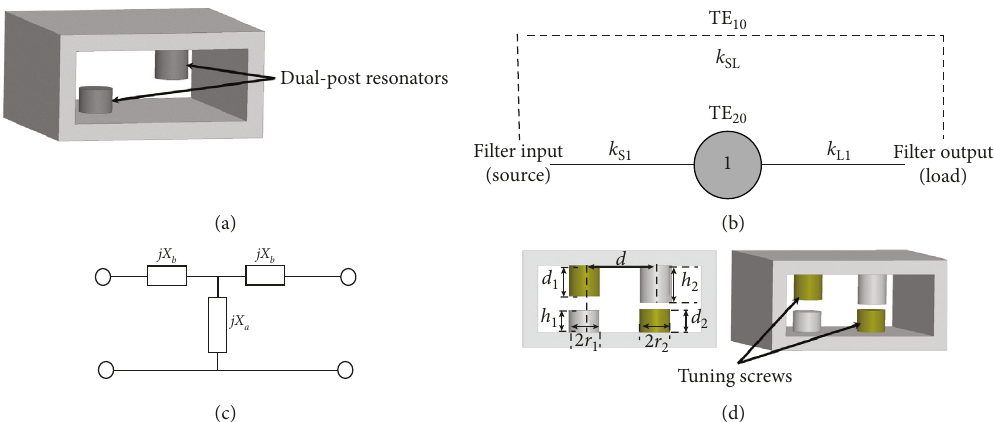
Figure 2: Dual-post resonator filter. (a) The dual-post resonators. (b) The DPR filter singlet schematic. (c) The DPR equivalent circuit. (d) The dual-post resonators and tuning screws variables.